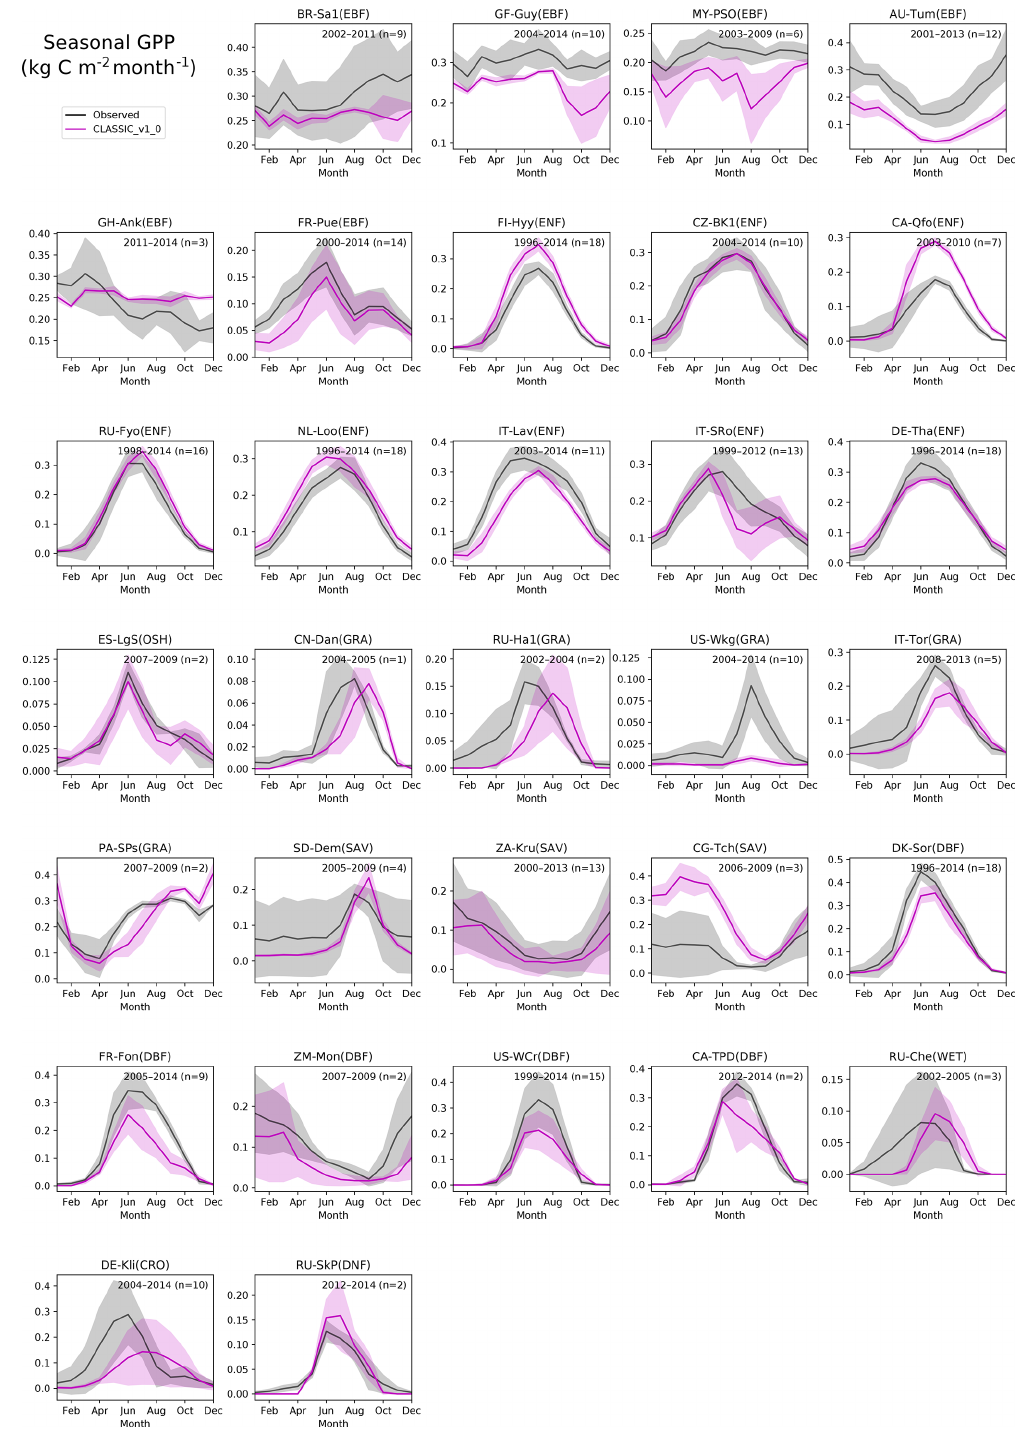
Figure 8. The mean seasonal cycle of GPP for 31 FLUXNET sites as simulated by CLASSIC. The IGBP biome of each site is listed alongside its FLUXNET site ID (see Table 1). Shaded regions indicate the standard deviation across the sample years. See caption of Fig. 5 for biome